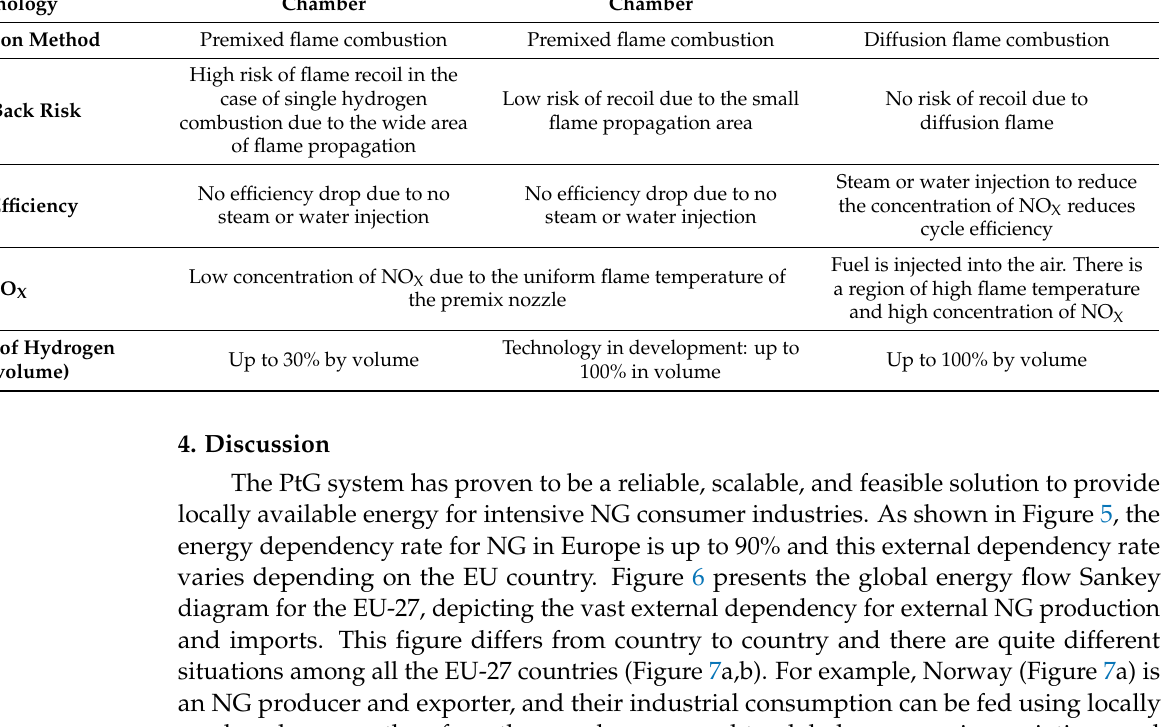
Figure 6. Energy Sankey diagram EU-27 2020, [45].